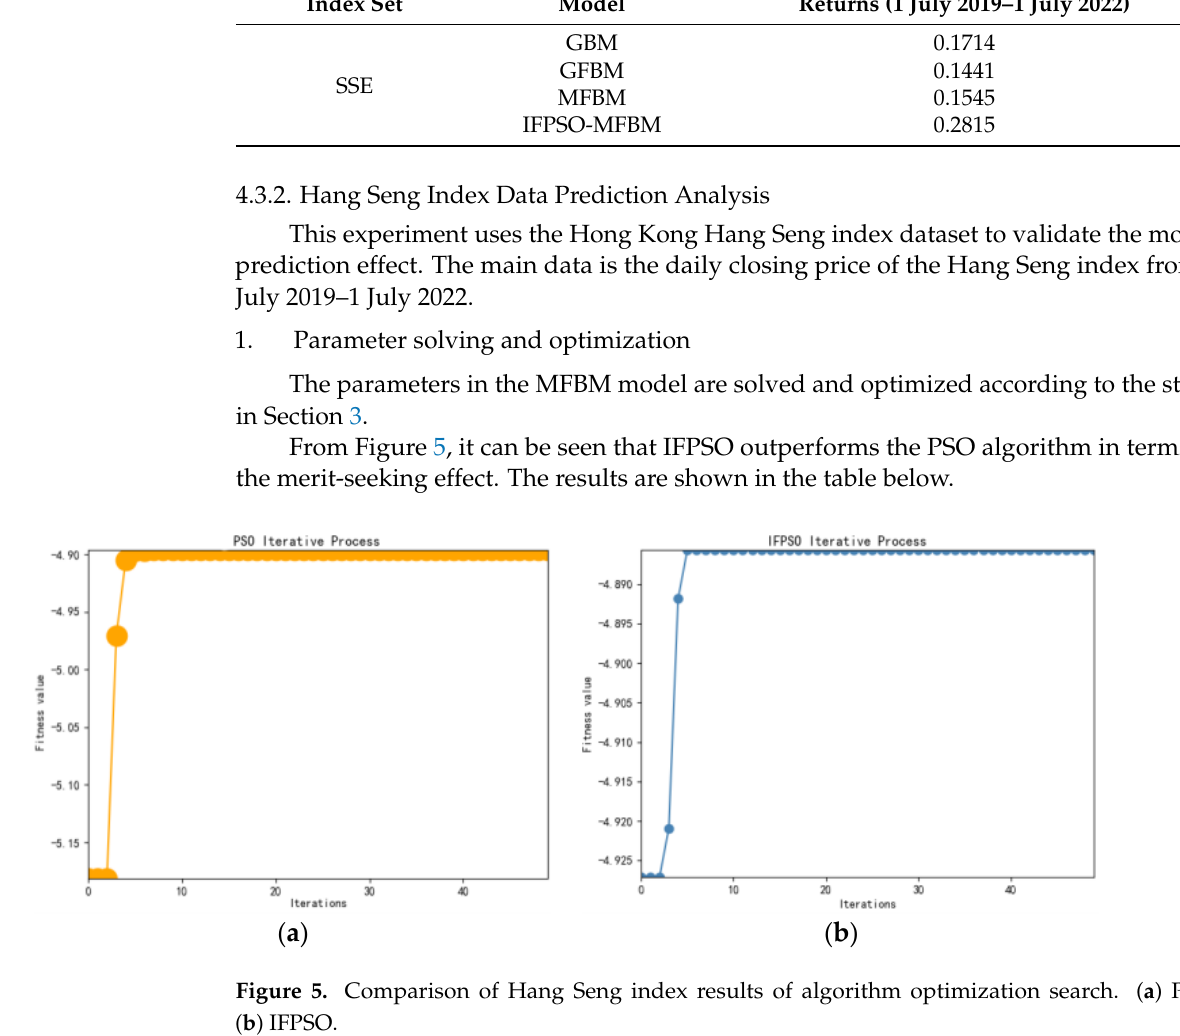
Table 5. Comparative analysis of SSE index returns under four models.